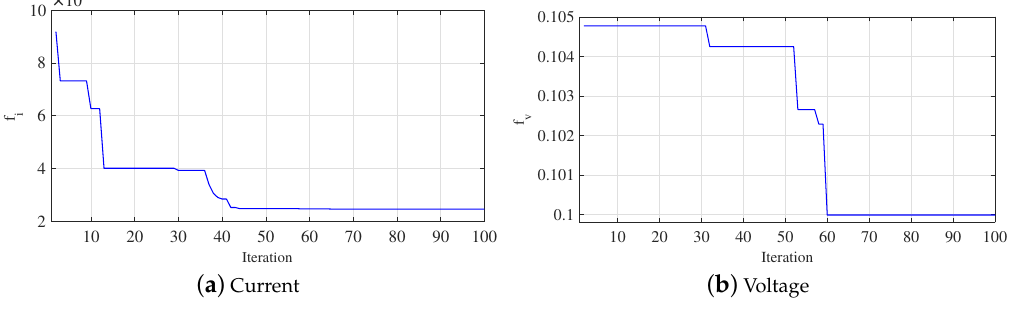
Figure 5. Evolution of the objective